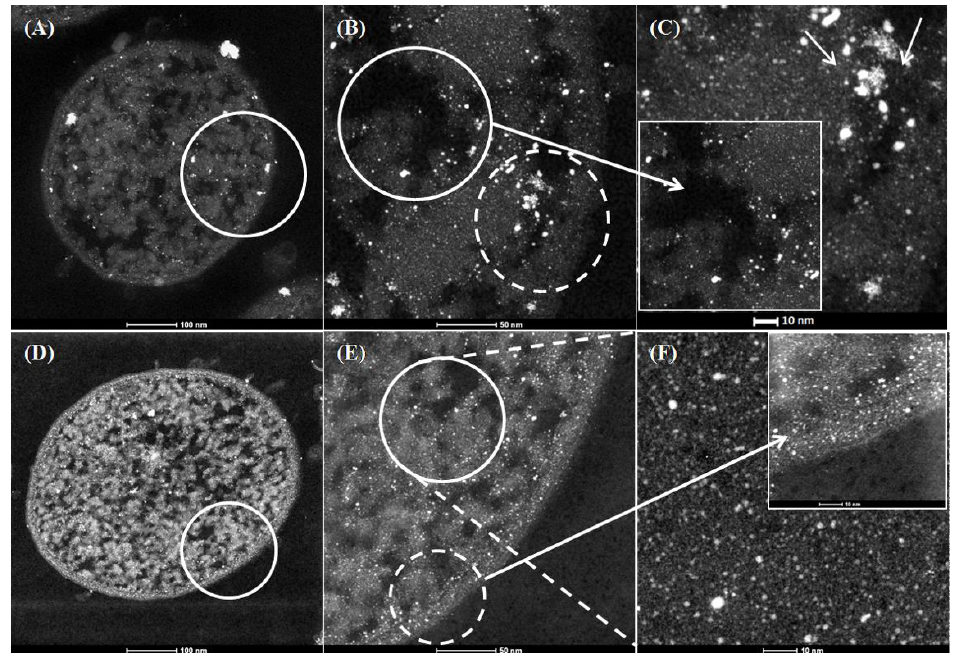
Figure 1. High-angle annular dark field scanning transmission electron microscope (HAADF–STEM) micrographs of Pd nanoparticles synthesized using 5 wt% Pd loading (1:20) on E. coli MC4100 from 2